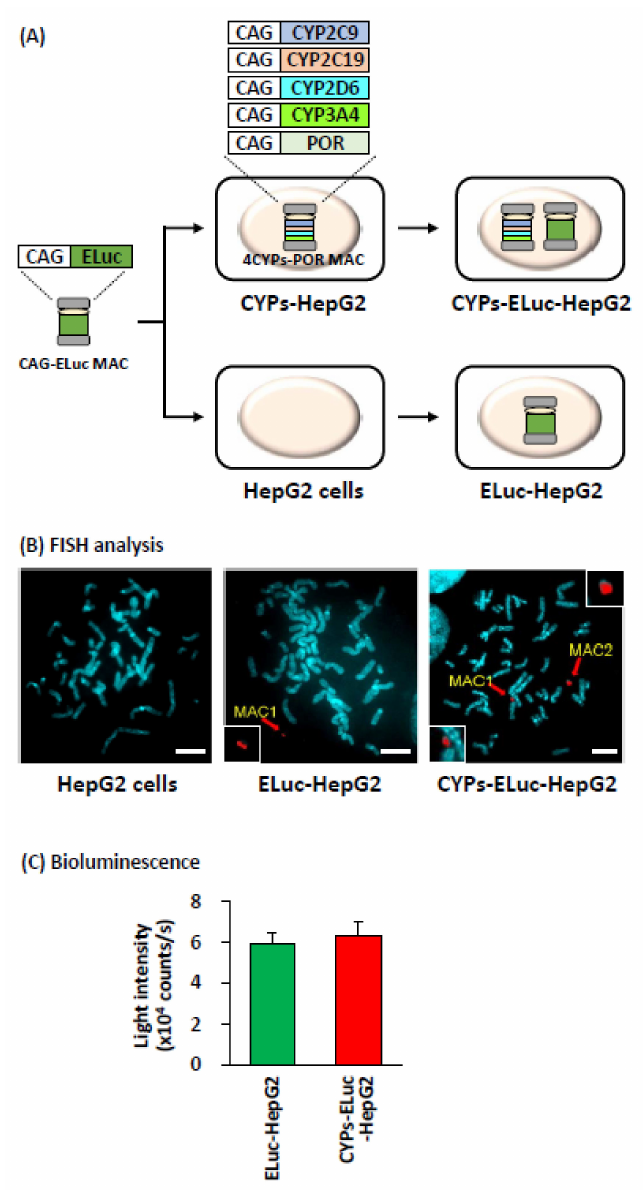
Figure 1. Generation of CYPs-ELuc-HepG2 and ELuc-HepG2 cells. ( A ) Schematic diagram for generating CYPs-ELuc-HepG2 and ELuc-HepG2 cells. CAG indicates CAG promoter. ( B ) FISH analysis of metaphase chromosome spreads from wild-type HepG2 cells (left panel), ELuc-HepG2 cells (middle panel), and CYPs-ELuc-HepG2 cells (right panel). Red arrows: MAC. Red signals: rhodamine-mouse Cot-1 DNA. Scale bar: 10 µ m. The insets show enlarged images of each MAC. ( C ) Bioluminescence intensity of ELuc-HepG2 and CYPs-ELuc-HepG2 cells. One day after seeding, bioluminescence intensity was measured non-destructively for 5 s. Error bars indicate standard deviations ( n =